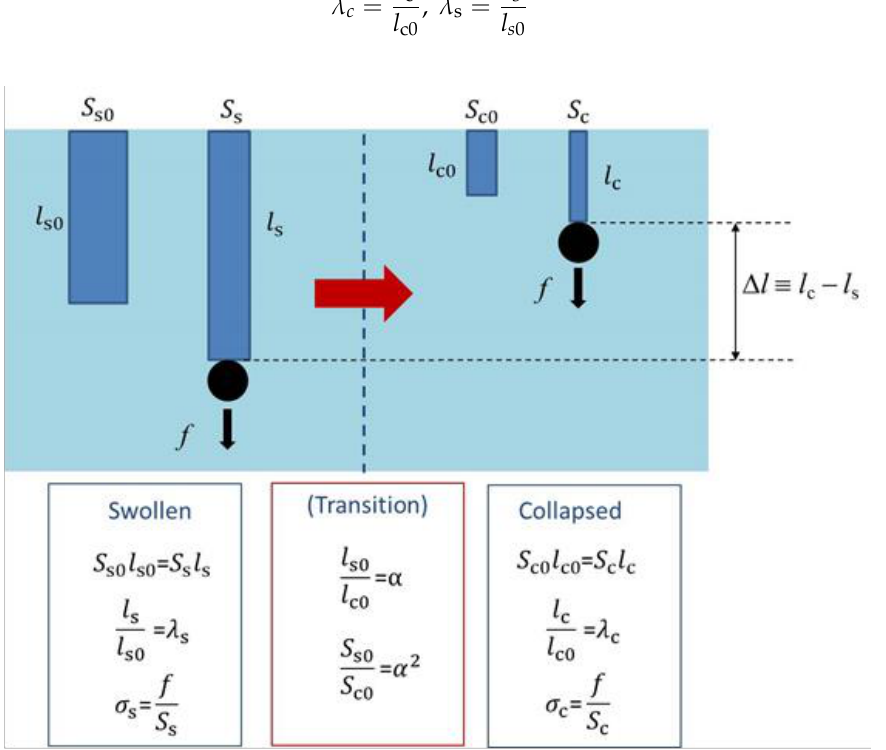
Figure 4. Schematic representation of the change in dimension of a polymer gel by loading as well as by transition. For details, see text.